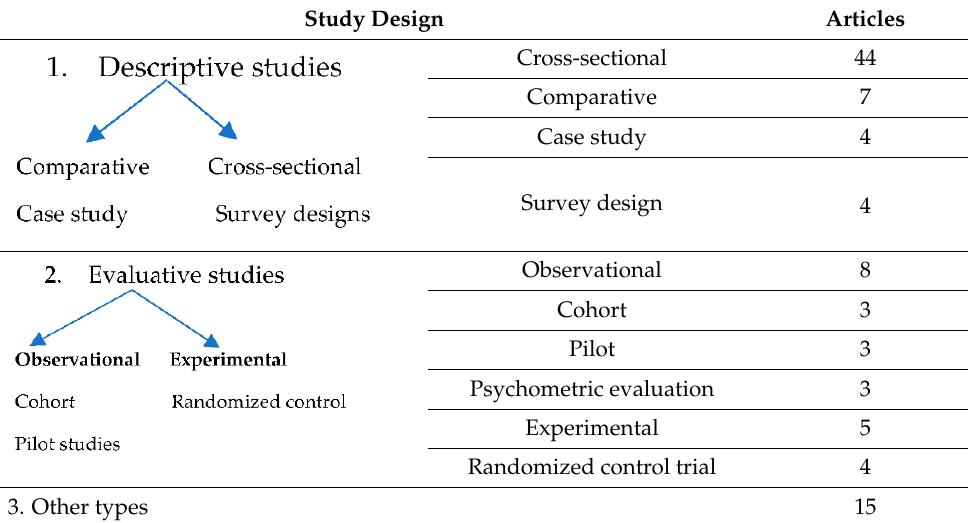
Table 8. Study design of top-cited articles of RULA and NMQ in WMSDs in regard to healthcare practitioners.